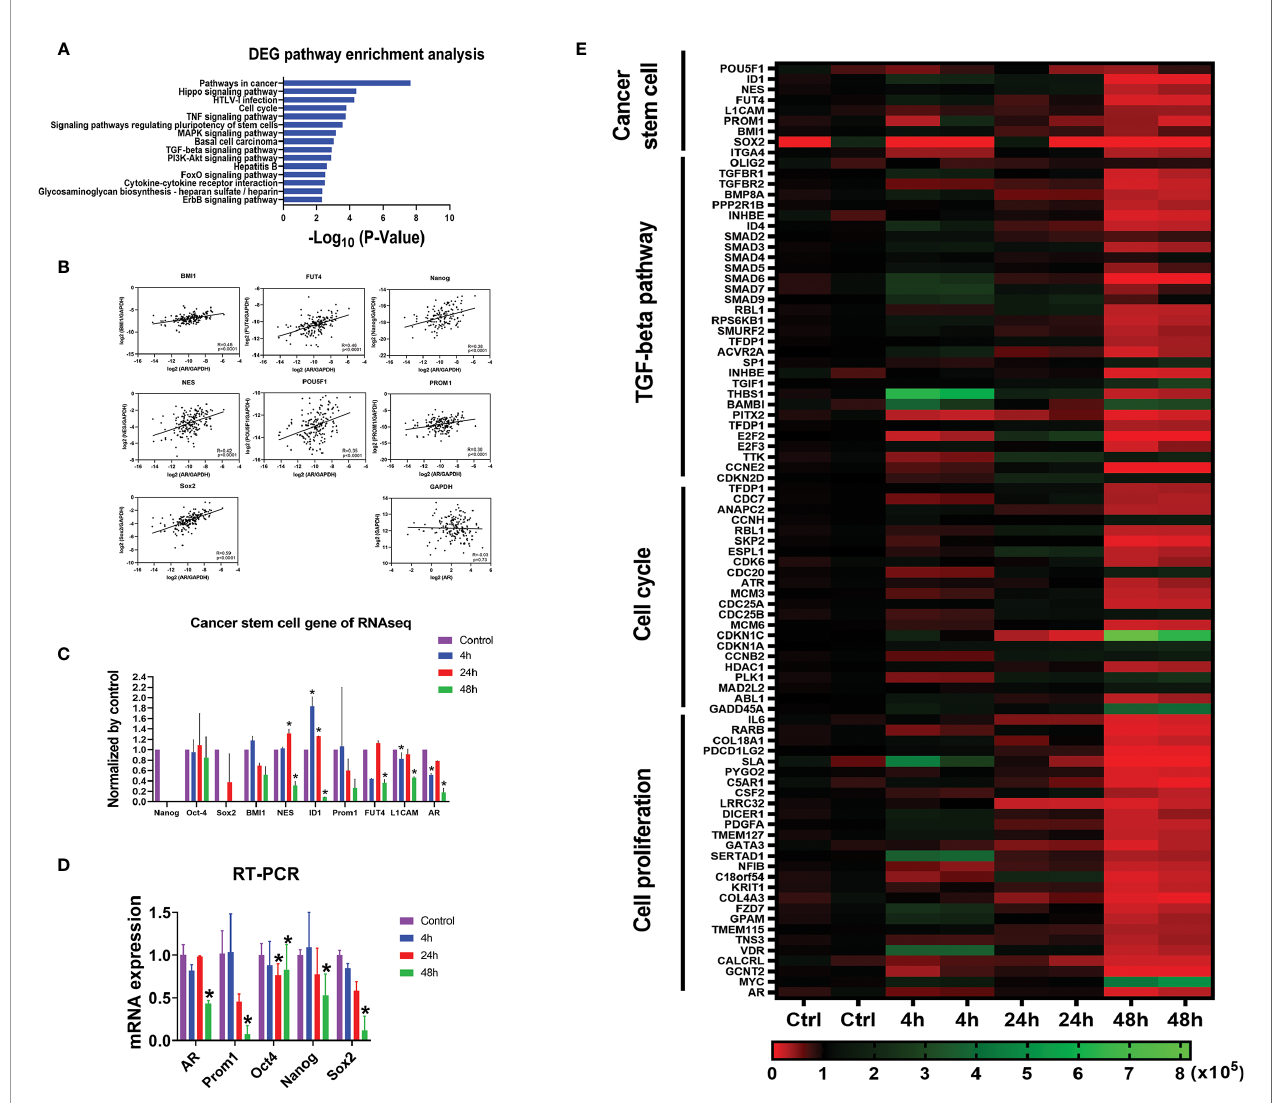
FIGURE 5 | AR positively correlates with CSC marker genes at mRNA expression level. (A) Gene Set Enrichment Analyses (GSEA) against the KEGG pathway database showing the top 15 pathways most signi fi cantly regulated in the U87MG cells with differentially expressed genes (DEGs) after the treatment of enzalutamide for 48 h. (B) The positive correlations of mRNA expressions between CSC marker genes and AR from in vivo RNA-seq results in GBM patients from TCGA database. GAPDH, a housekeeping gene, showed no correlation with AR (R = -0.03). (C) mRNA expression levels of various CSC marker genes in U87MG cells cultured in vitro before and after the treatment of enzalutamide (80 µM) from RNA-seq results from our laboratory. CD133 is an alias name for Prom1. (D) Quantitative RT-PCR results of the representative CSC genes after the treatment of enzalutamide. (E) Heatmap of the genes speci fi c for cancer stem cell, TGF- b signaling pathway, cell cycle, and cell proliferation responding to enzalutamide treatment in U87MG cells at different time points. The scale bar at the bottom represents the normalized read counts of the genes from RNA-seq results. *p <